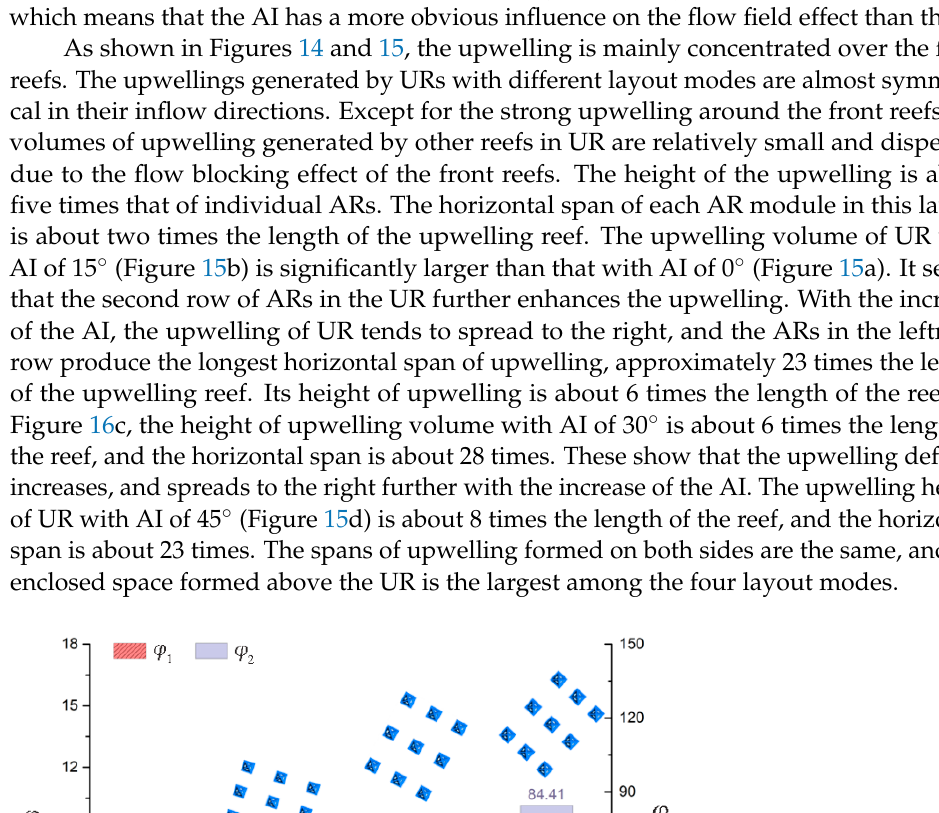
Figure 13. The φ 4 of URs .